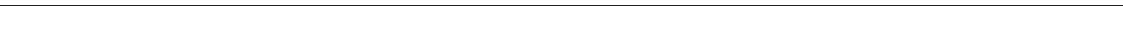
Fig. 1 Defective myotube formation by CDC50A-de fi cient and ATP11A-de fi cient myoblasts. a – d Aberrant morphologies of PS fl ippase-de fi cient myotubes. a Syncytia formed by WT and CDC50A-de fi cient or ATP11A-de fi cient C2C12 myoblasts were visualized by immuno fl uorescent staining with anti-MyHC antibody (differentiated cells, red) and DAPI (nuclei, cyan). b Left: cell fusion evaluated as percentages of syncytia containing ≥ 50 nuclei in a . Right: polarized elongation evaluated as percentages of syncytia with aspect ratios ≥ 3 in a . c Syncytia formed by human primary myoblasts transfected with control, CDC50A or ATP11A siRNA were visualized by immuno fl uorescent staining with anti-MyHC antibody and DAPI. d Left: cell fusion evaluated as percentages of syncytia containing ≥ 16 nuclei in c . Right: polarized elongation evaluated as percentages of syncytia with aspect ratios ≥ 3 in c . e , f Rescue of morphologies in PS fl ippase-de fi cient myotubes by overexpression of PS fl ippase complex components. e Syncytia formed by WT, CDC50A-de fi cient or ATP11A-de fi cient C2C12 myoblasts expressing FLAG-tagged CDC50A, ATP11A, ATP11B or ATP11C were visualized by immuno fl uorescent staining with anti-MyHC antibody and DAPI in Supplementary Figure 3b. Left: cell fusion evaluated as percentages of syncytia containing ≥ 50 nuclei. Right: polarized elongation evaluated as percentages of syncytia with aspect ratios ≥ 3. f Localization of FLAG-tagged proteins expressed in CDC50A-de fi cient or ATP11A- de fi cient C2C12 myoblasts. g , h PS exposure on PS fl ippase-de fi cient myoblasts. g Flow cytometry analysis of inward translocation ( fl ip) activity of fl uorescence-labelled PS (NBD-PS) at the plasma membrane of WT, CDC50A-de fi cient and ATP11A-de fi cient C2C12 myoblasts. h Flow cytometry histogram of WT, CDC50A- and ATP11A-de fi cient C2C12 myoblasts labelled with annexin V-GFP. i , j Mislocalization of cortical actomyosin in PS fl ippase- de fi cient myotubes. i Localization of F-actin (phalloidin, red) and NMIIA (anti-NMIIA antibody, green) in WT, CDC50A-de fi cient and ATP11A-de fi cient C2C12 syncytia. Arrows indicate syncytia with diminished peripheral NMIIA accumulation. j Cortex vs. cytoplasm ratio of F-actin and NMIIA signals in i . **** P < 0.0001 (Student ’ s t -test). NS not signi fi cant, n sample number. Bar graphs represent mean ± S.E.M. Box and whiskers graph-line: median, box: upper and lower quartiles, whiskers: maxima and minima. Scale bars: 100 μ m ( a , c ), 20 μ m ( f , i